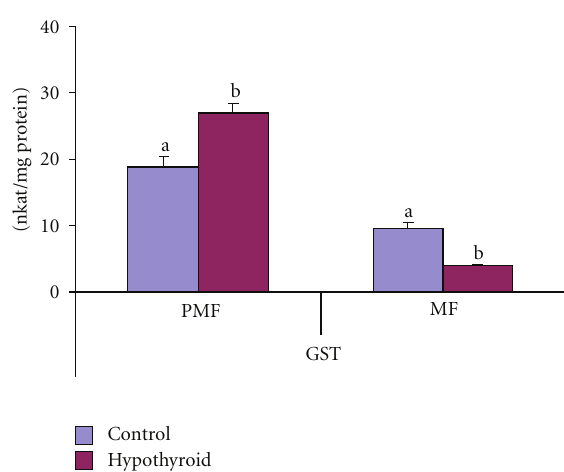
Figure 7: E ff ect of neonatal PTU treatment on glutathione peroxi- dase activity (GPx; nkat/mg protein) in postmitochondrial fraction (PMF) and mitochondrial fraction (MF) of testes of rats. Data are expressed as mean ± S.D. of 5 observations and subjected to unpaired Student’s t -test. Statistical significance was accepted at P < 0 . 05. Control and hypothyroid groups were found to di ff er signifi- cantly at P < 0 . 05 as represented by superscripts of di ff erent letters.